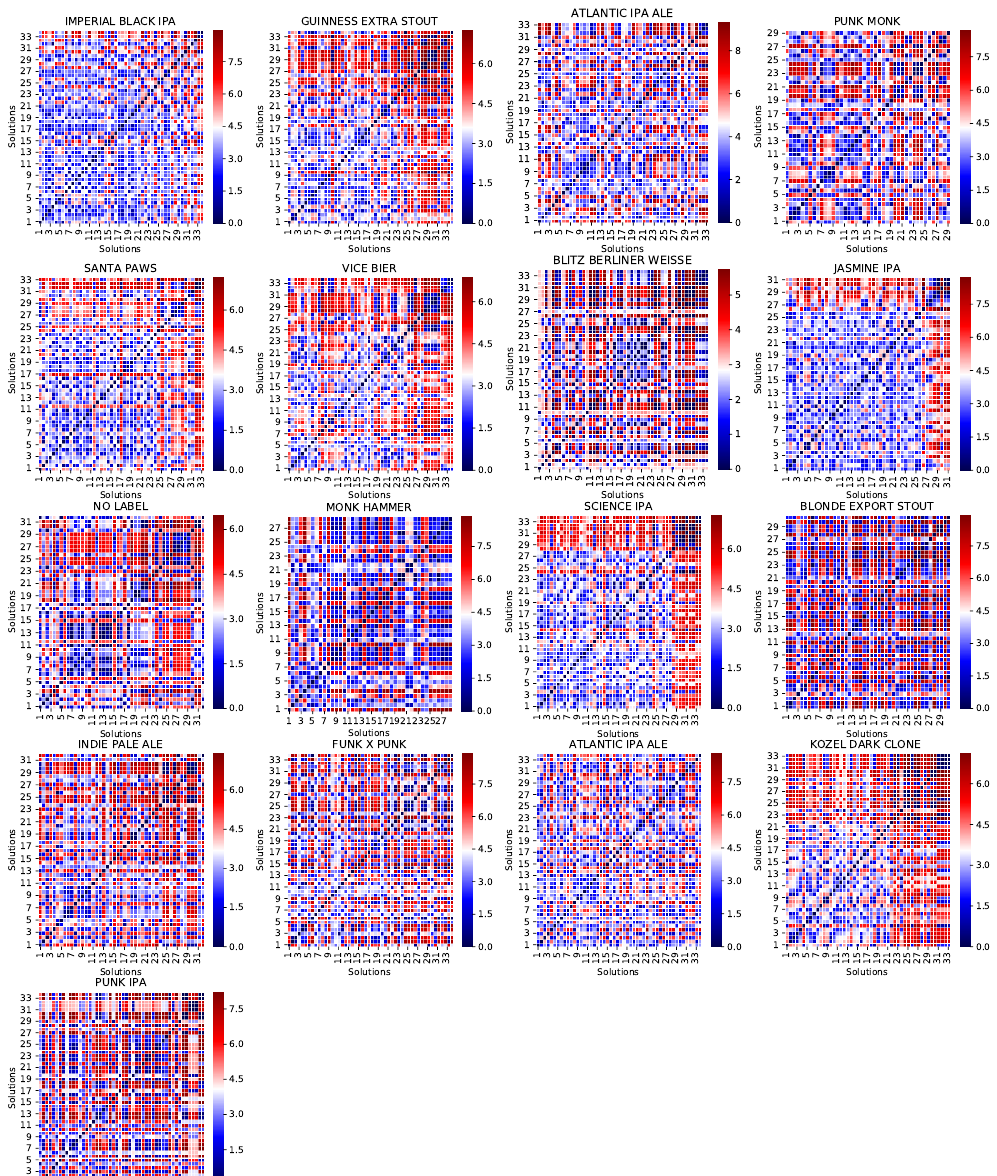
Figure A2. Solution vector distances. Visualising the distance matrices of the solution vector in the first 12 products. Note that products 4, 7, and 14 are not included as they have not been optimised. As for the rest of the products, only the valid solutions are considered (e.g., while Imperial Black IPA has 50 valid solutions, Punk Monk has 43). These graphs illustrate the diversity in the generated solutions. Table 5 presents the numerical summary of solution distance